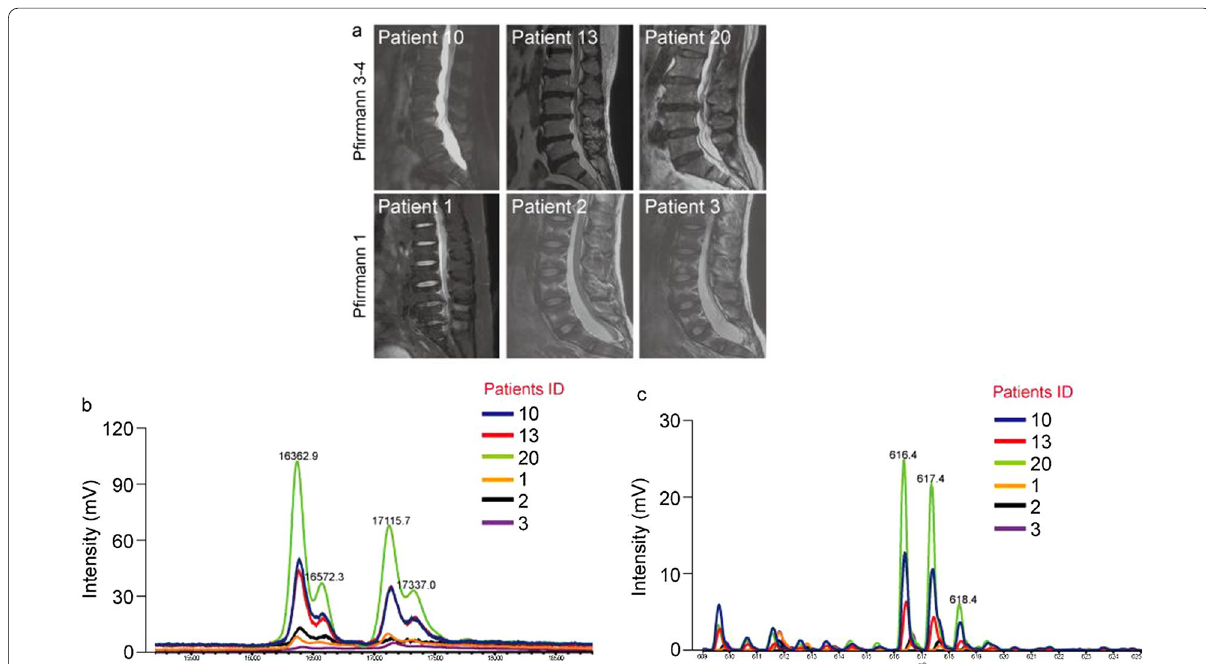
Fig. 3 Hb and heme levels are positively correlated with the Pfirrmann classification of disc degeneration. a Representative MRI images from 3 patients with LDH and 3 control patients with tethered cord syndrome. b The spectra corresponding to the MRI images measured by a high-mass detector. c The spectra corresponding to MRI images in the low-mass